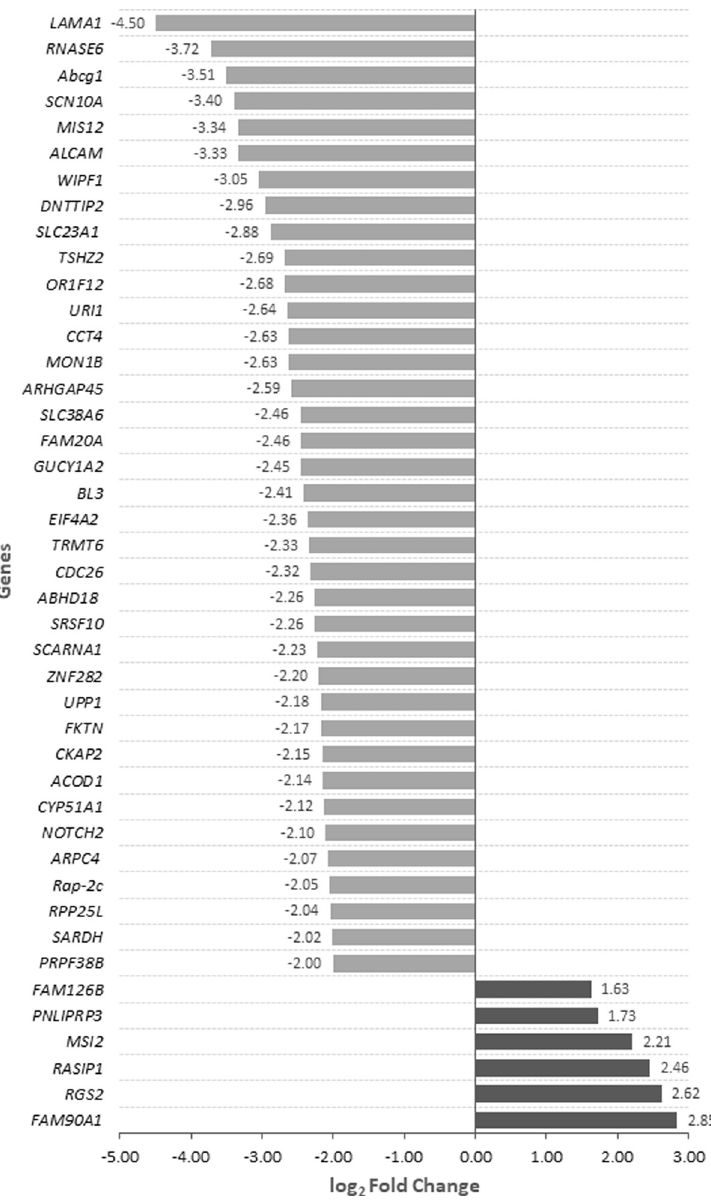
Fig 4. Upregulated (dark grey) and down-regulated (light grey) protein coding genes under heat stress conditions. The DA genes passed the filters of padj < 0.05 and absolute log2FoldChange � 1.5. In this figure, we only show genes that presented padj < 0.05 and absolute log2FoldChange �